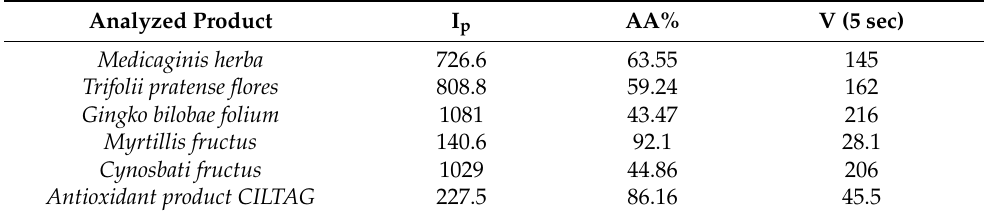
Table 6. Values of the chemiluminescent signal as a function of time and of the antioxidant activity in the presence of hydroalcoholic solutions.